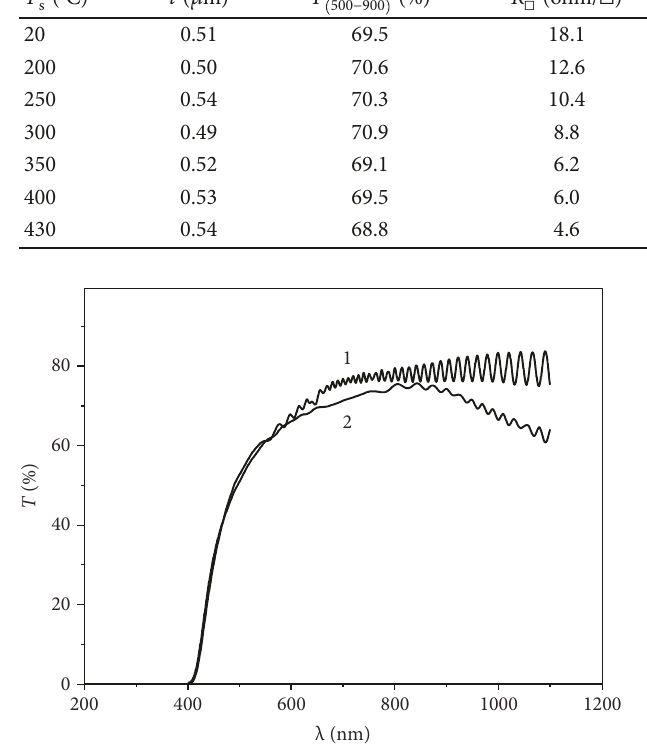
Figure 2: Optical properties of ITO/polyimide systems before (1) and after (2)